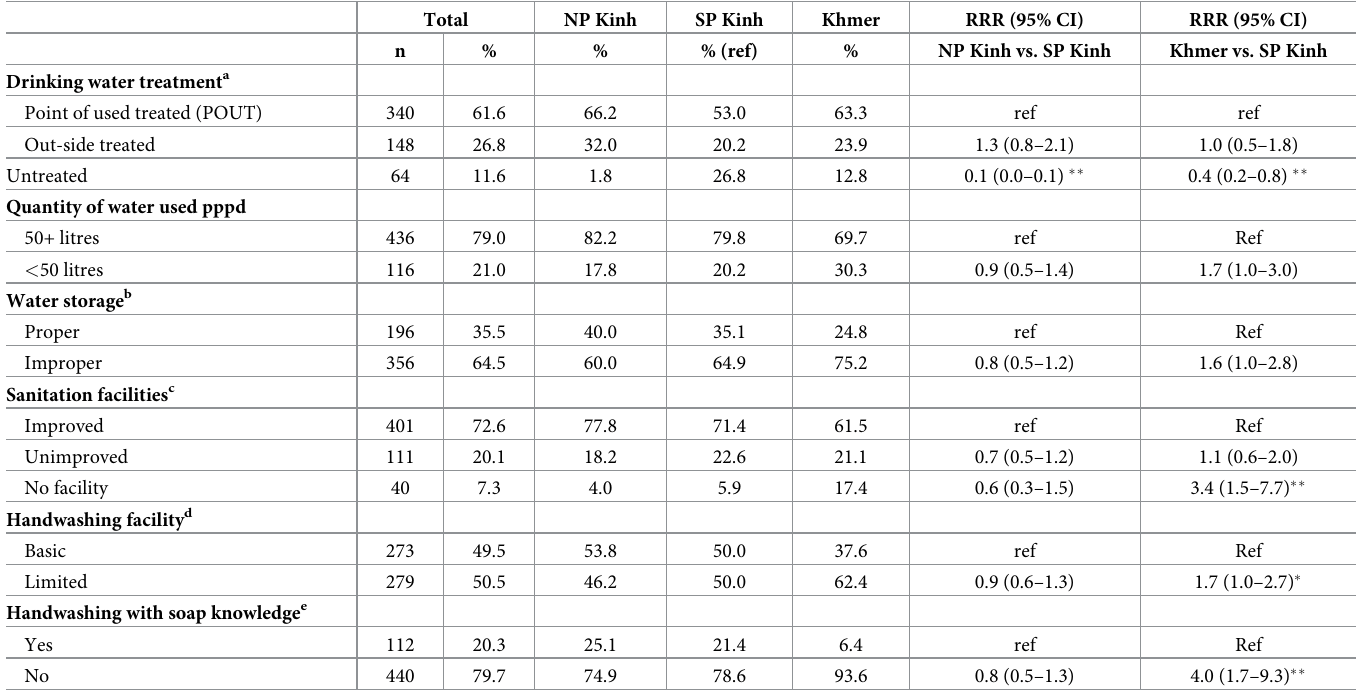
Table 2. Differences in WASH components by population